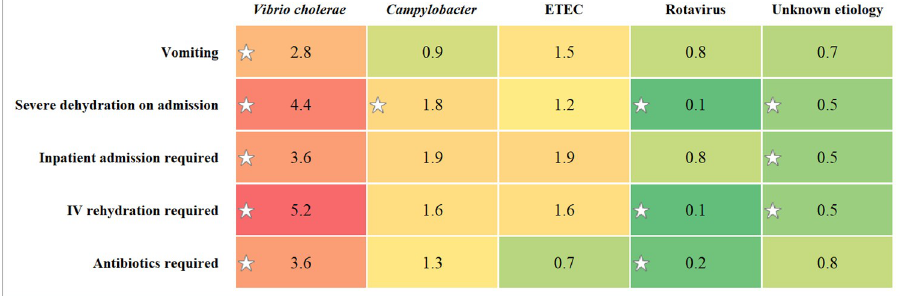
Fig 4. Relative effect of selective enteric pathogens on disease severity during the epidemic. The value in each cell is the age-adjusted odds ratio of a particular attribute of disease severity for a specific pathogen. The cells are coded using a red-yellow-green color gradient. The red end of the spectrum represents increased odds, and the green end represents decreased odds. The darker the shade, the stronger the effect. Asterisk indicates a statistically significant (P < 0.05) odds ratio. The age-adjusted odds ratios and the corresponding P values were obtained from logistic regression models. To simplify the analysis, coinfections were ignored in the models. ETEC, enterotoxigenic Escherichia coli